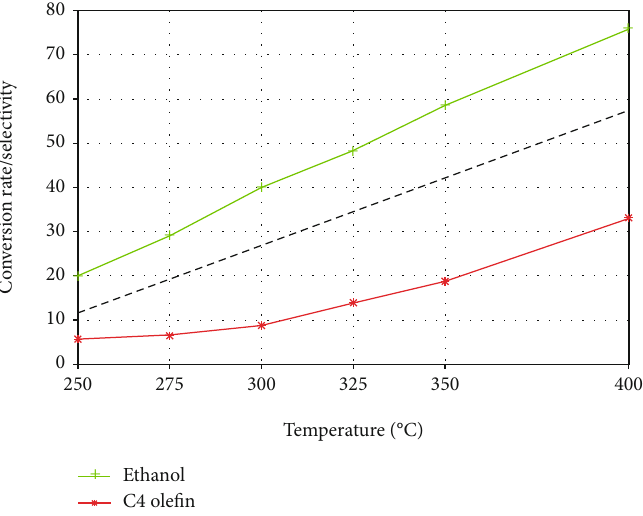
Figure 2: C ole fi n selectivity histogram. 4